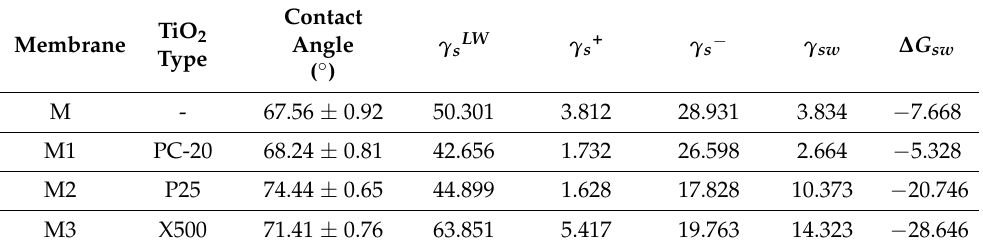
Table 5. Static water contact angle, surface tension components, total interfacial tension, and free energy of interaction between membrane surface and water molecules, for the neat PVDF membrane and PVDF/TiO 2